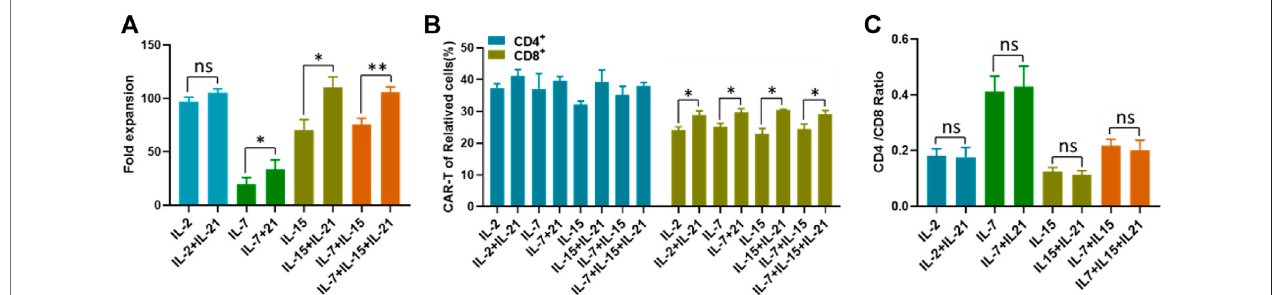
FIGURE 2 | IL-21 enhances the proliferation of T cells. (A) The number of T cells in different culture conditions was counted with in automatic cell counter on the 12th dayaftertransfection.Thefoldexpansionwascalculatedastotalnumberofproliferatingcells/thestartingcellnumber. (B) Thetransfectionef fi ciencyofCD4 + Tcells and CD8 + cells was calculated on the 12th day after transduction. (C) CD4/CD8 ratio of CD3 + T cells was calculated on day 12 after T cell transfection. Data representative of three separate experiments are shown (mean ± SEM). Statistical signi fi cance was tested using Student ’ s t -test (* p < 0.05, ** p <